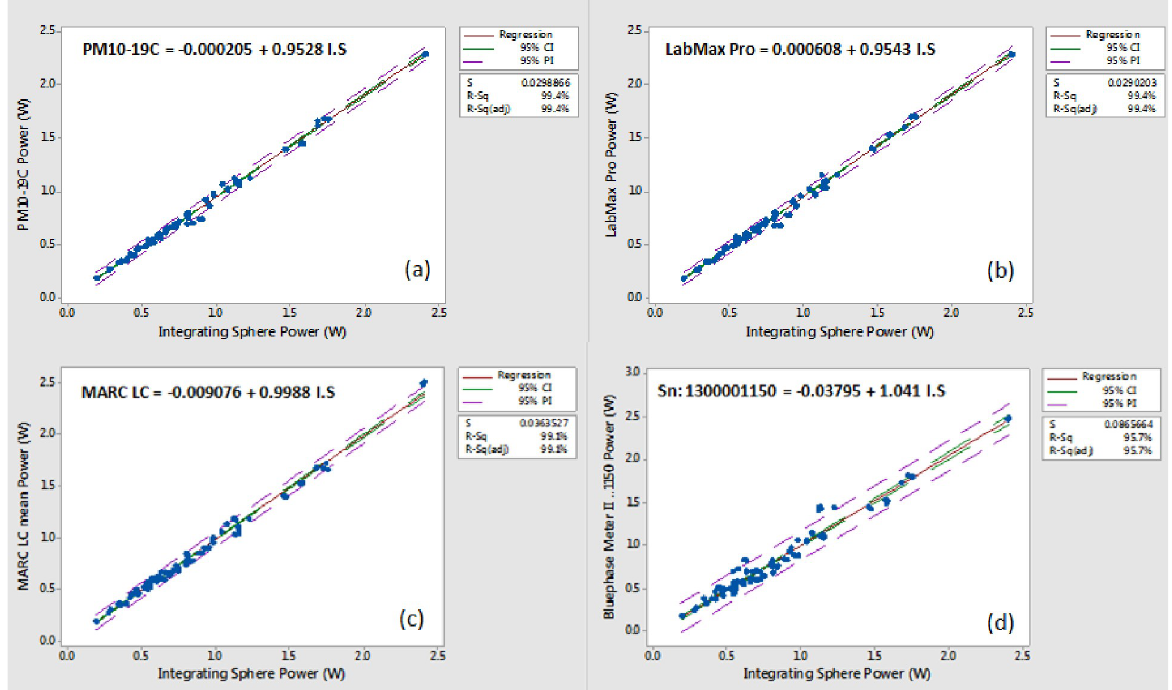
Fig 1. Regression analyses and fitted line plots with 95% confidence and prediction intervals for mean power recordings of the Type I and Type II LED-LCUs using (a) the PM10-19C thermopile, (b) the LabMax Pro, (c) the MARC LC and, (d) the BMII (sn: 1300001150). For each analysis, the integrating sphere gold standard power (W) data was used as the predictor variable. Several high outlier results were noted in Fig 1 (d) for Type II LED-LCUs (I LED in standard and high output modes, Pencure VII and Fusion 5 (Blue Head) in Plasma mode). As the BM II is only designed to generate irradiance data for light guide tip diameters between 6 and 12 mm, the values generated for the 4 mm and 13 mm tips of the Demetron A2 LED LCU were based on programming the nearest tip diameter value (6 mm and 12 mm, respectively) to obtain the readings which were then corrected for area